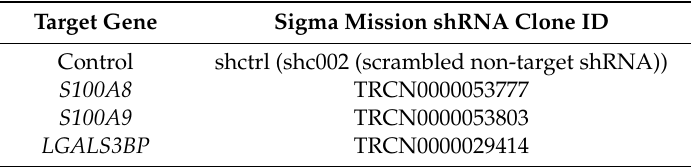
Table 2. Lentiviral shRNA constructs for silencing gene expression via RNA